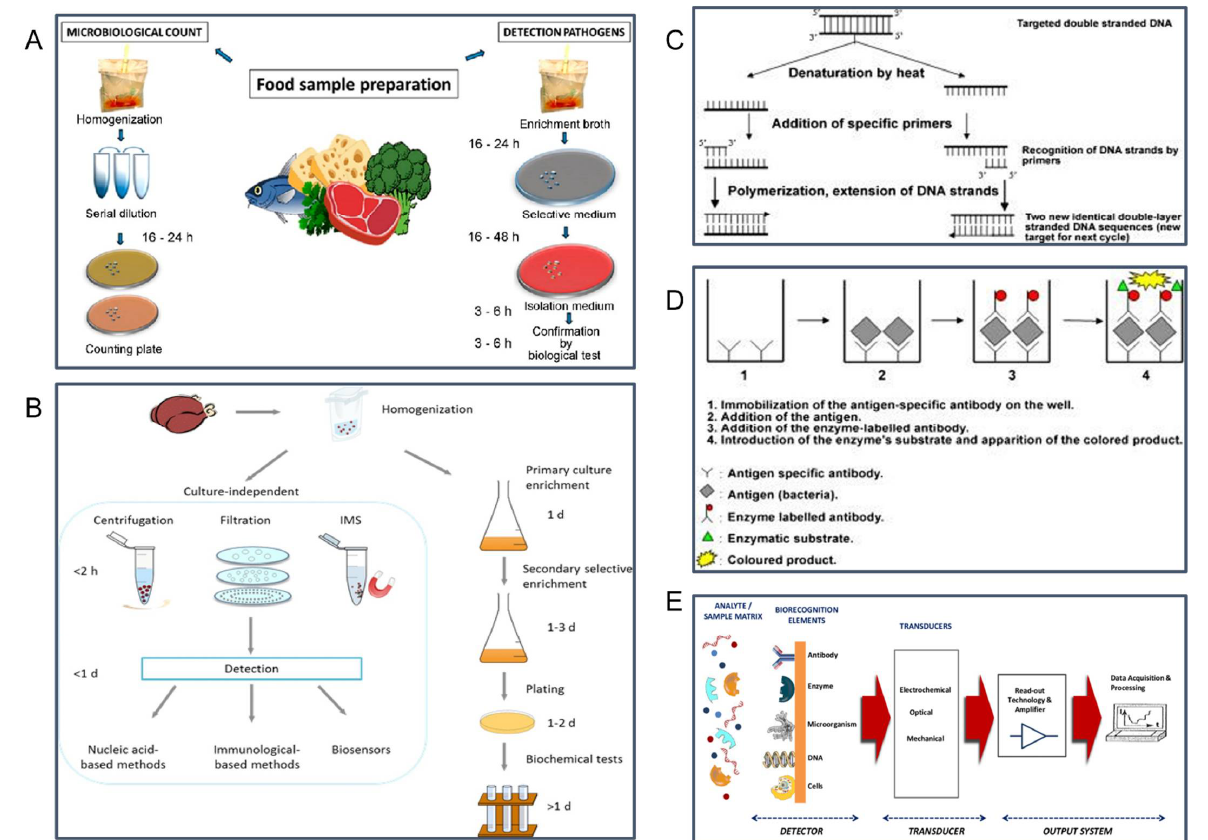
Figure 2. ( A ) Conventional cell culture and colony counting method for foodborne pathogen detection. ( B ) Cultureindependent vs. conventional culture enrichment methods for food pathogen de-